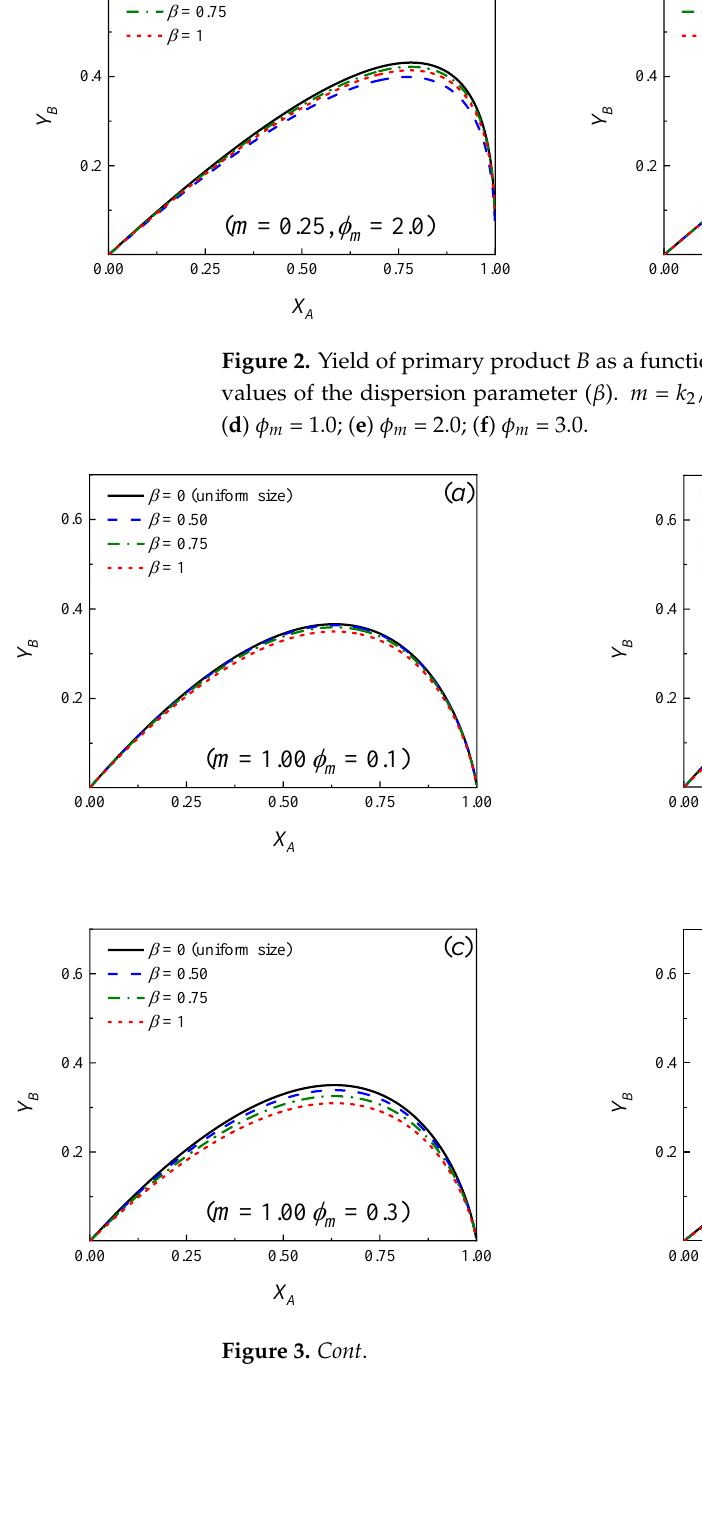
Figure 2. Yield of primary product B as a function of the conversion of the reactant A for different values of the dispersion parameter ( β ). m = k 2 / k 1 = 0.25. ( a ) ϕ m = 0.1; ( b ) ϕ m = 0.2; ( c ) ϕ m = 0.3; ( d ) ϕ m = 1.0; ( e ) ϕ m = 2.0; ( f ) ϕ m = 3.0.